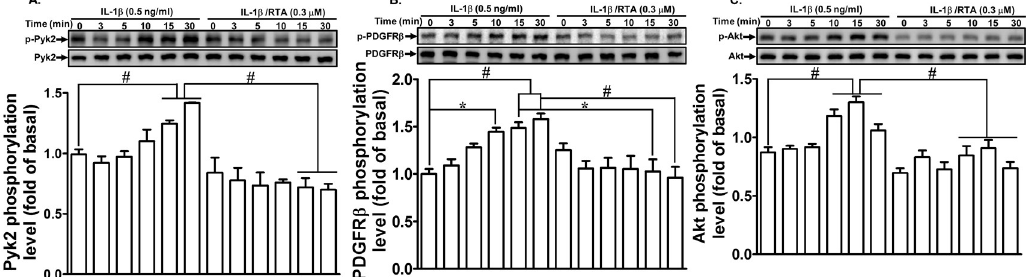
Figure 2. RTA 408 attenuates the IL-1 β -induced proMMP-9 expression via suppressing the phosphorylation of Pyk2, platelet-derived growth factor receptor β (PDGFR β ), and Akt. Cells were pretreated with RTA 408 (0.3 µ M) for 4 h, and then incubated with IL-1 β (0.5 ng / mL) for the indicated time intervals (3, 5, 10, 15, and 30 min). The cell lysates were assayed by western blot to detect the phosphorylation of Pyk2 ( A ), PDGFR β ( B ), and Akt ( C ) using their respective phosphorylated antibody. Data analysis and processing are described in the section “Statistical Analysis of Data.” * indicates p < 0.05; # indicates p < 0.01, as compared between the indicated groups. The figure represents one of three individual experiments.